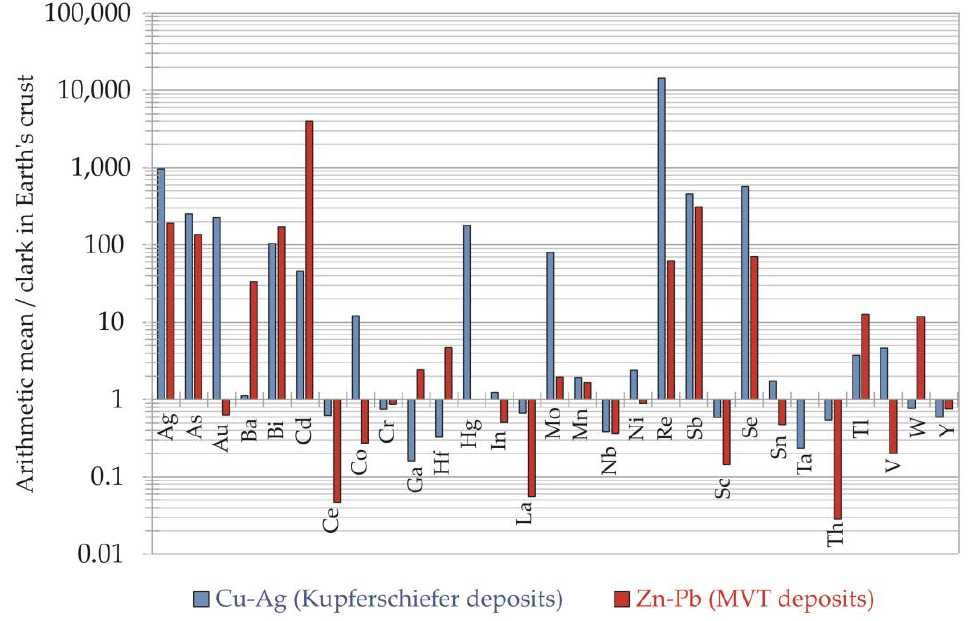
Figure 20. Comparison of the arithmetic mean content of trace elements in bulk-rock analyses of samples from the Cu-Ag and Zn-Pb sediment hosted deposits in Poland relative to their average contents in the Earth's crust [93].